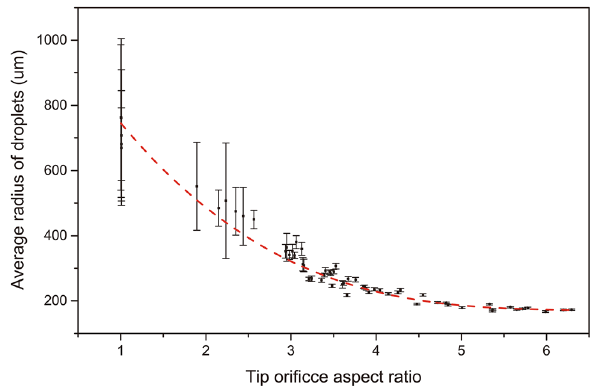
Figure 4. Water droplets generated by a series of deformed pipette tips (default 200 µL tips used in this work) with various tip orifice aspect ratios. Generally, for a certain type of tips, the higher the tip orifice aspect ratio, the more uniform the generated droplets.